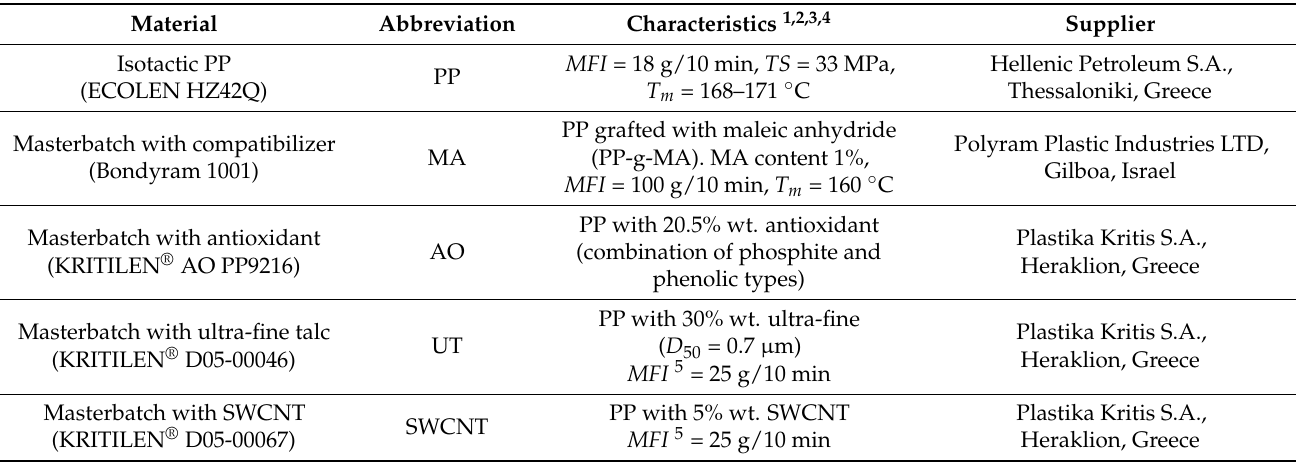
Table 1. Important characteristics of the used